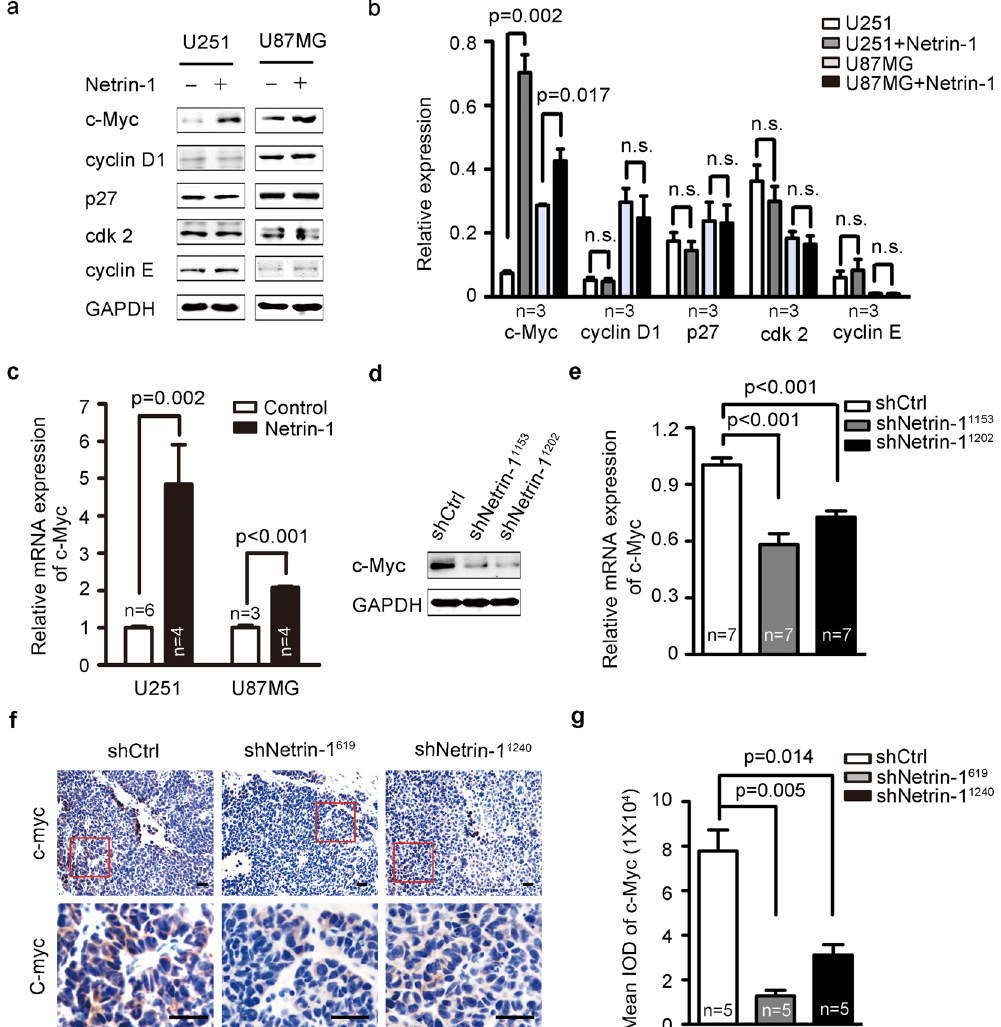
Figure 5. Netrin-1 promoted the expression of the oncogene c-Myc. ( a ) Immunoblotting analyses of the expression of selected oncogenes in U251 and U87MG cells after stimulation with recombinant human netrin-1. ( b ) Quantification of c-Myc, cyclin D1, p27, cdk2 and cyclin E expression using Gel-Pro Analyzer 4 software. ( c ) c-Myc expression was detected by real-time PCR in U251 and U87MG cells in the absence or presence of netrin-1. ( d ) Western blotting analyses of c-Myc in U251 cells that were infected with lentivirus expressing shCtrl or shNetrin-1. GAPDH was used as the loading control. ( e ) c-Myc expression was detected by real-time PCR in U251 cells that were infected by lentivirus expressing shCtrl or shNetrin-1. ( f ) Representative images of c-Myc staining in U251-derived tumor sections. Boxed areas in the top row defined regions shown at a higher magnification in the bottom row. Scale bar: 50 µ m. ( g ) Relative expression of c-Myc in U251-derived tumors. The mean IOD of c-Myc was calculated using Image-Pro